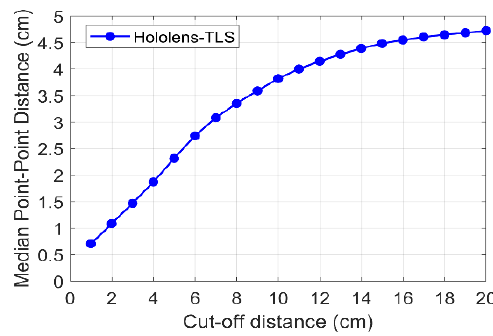
Figure 8. Median point-point distance between the Hololens mesh and the registered laser scanner point cloud.